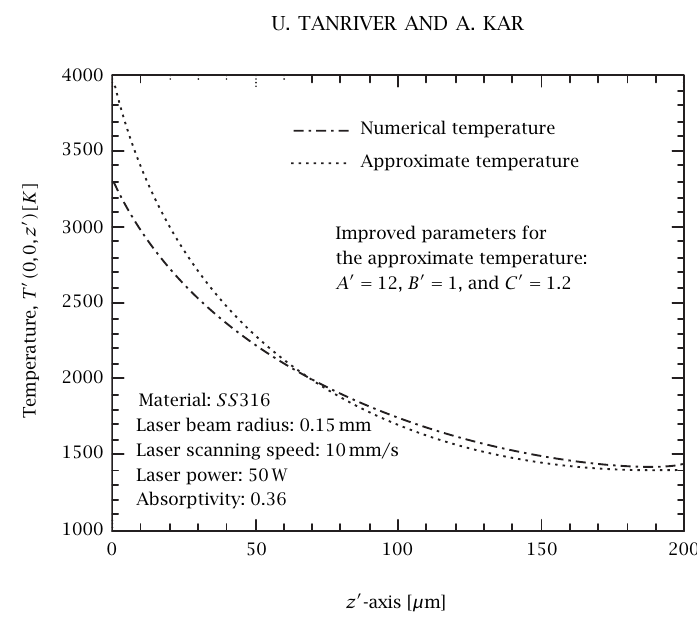
Figure 2.5 . Comparison between the numerical and improved approximate temperatures ( r = 0 case).